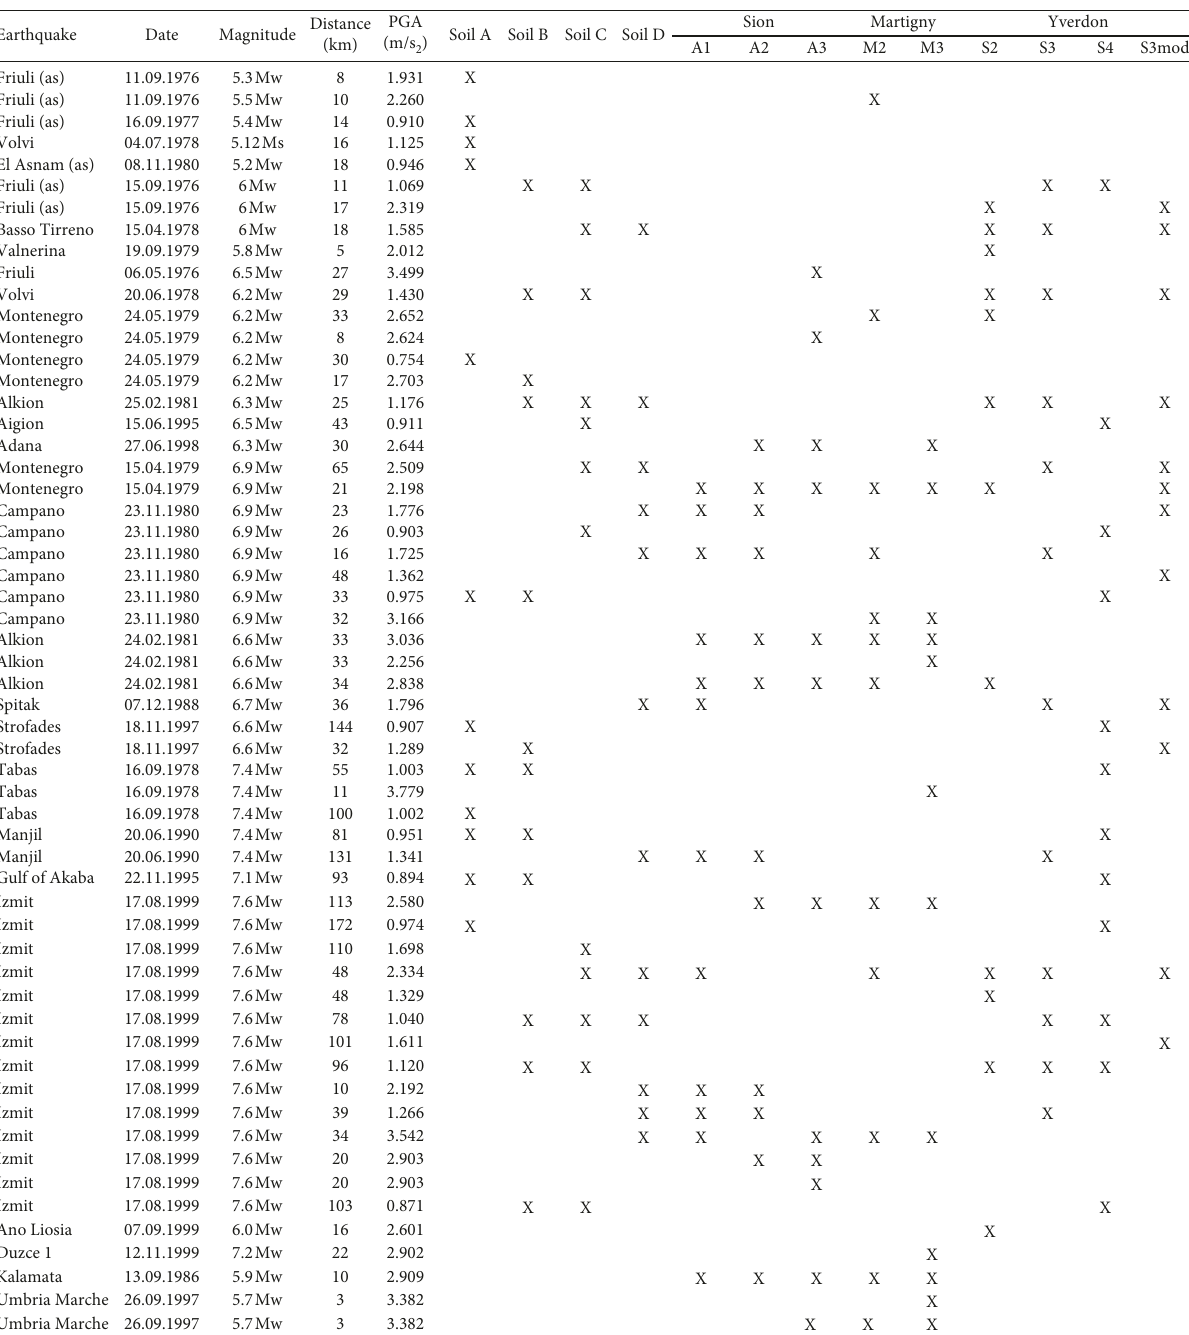
Figure 16: Main characteristics of the selected records and their distribution in the different sets of the twelve recordings each (as �